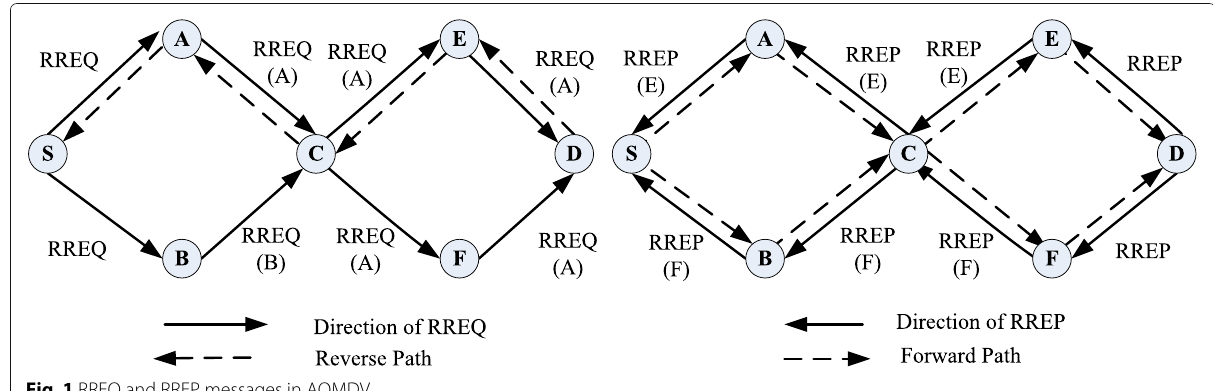
Fig. 1 RREQ and RREP messages in AOMDV